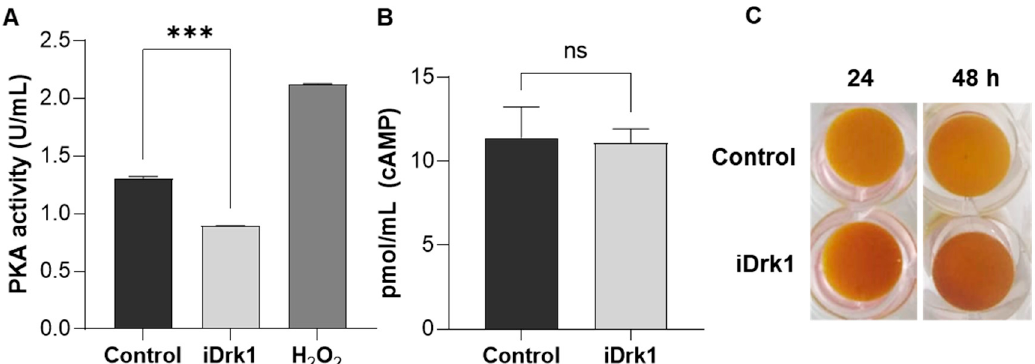
Figure 5. PKA activity and cAMP quantification in P. brasiliensis after incubation with iDrk1 ( A ) Quantification of PKA activity and ( B ) dosage of P. brasiliensis cAMP after 24 h incubation with 25 µ g/mL of iDrk1, where p -value ≤ 0.001 (***). ( C ) After 24 and 48 h of yeast incubation in the presence of the inhibitor, the cells were stained with a 0.2% iodine and 0.4% potassium iodide solution to assess glycogen accumulation.